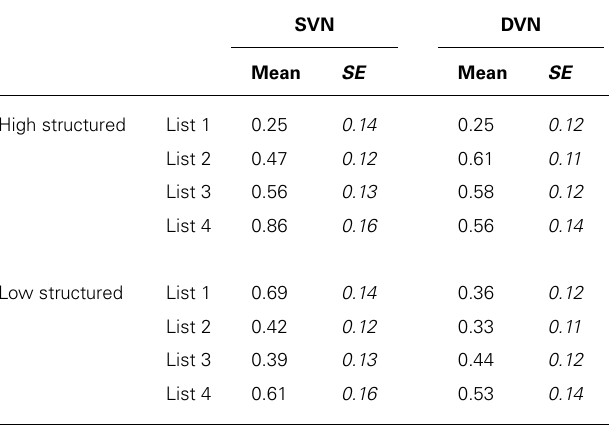
Table 4 |The mean number of correctly recalled words under SVN and DVN for high- and low-structured lists 1–4.